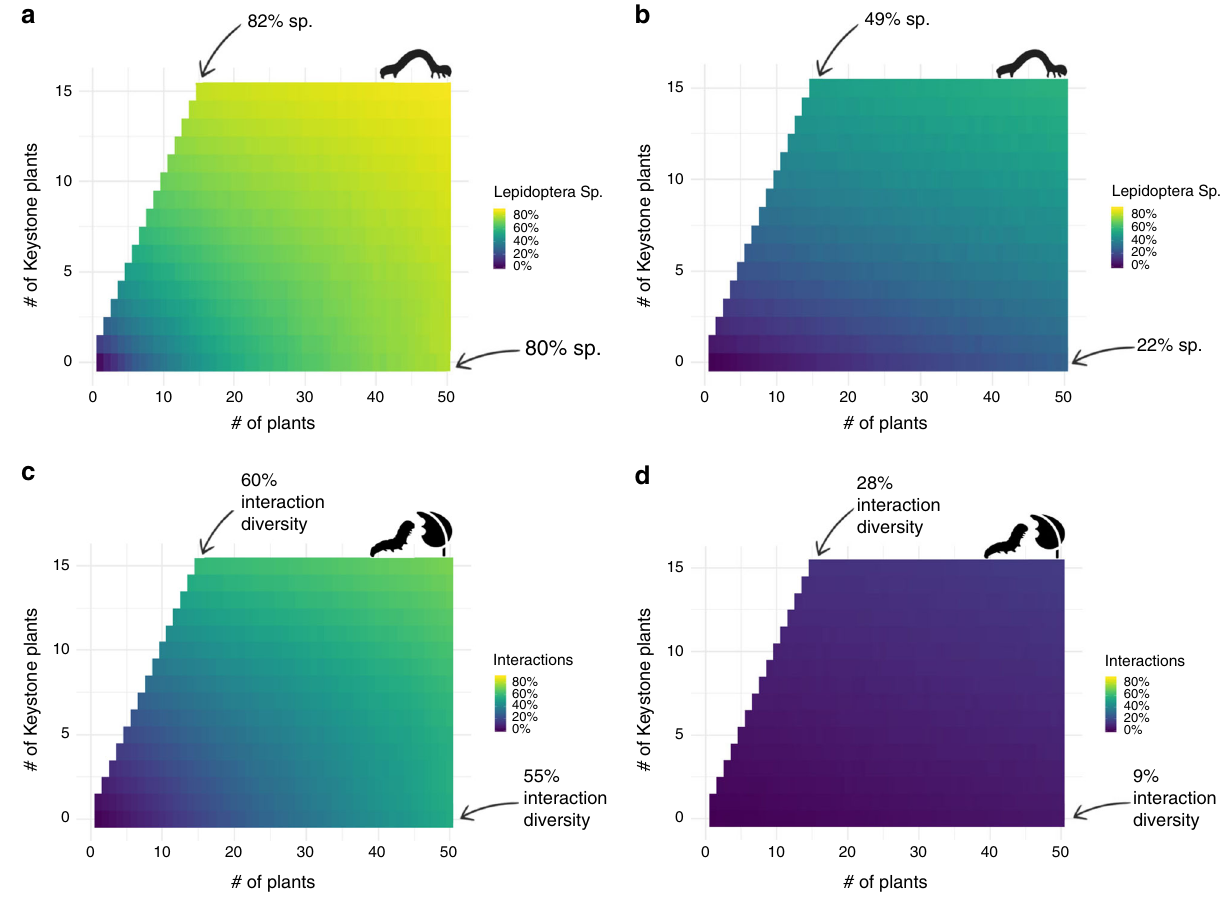
“ Fig. 3 including woody and herbaceous keystone plants increases the ef fi cacy and ef fi ciency of the restoration of Lepidoptera diversity. Simulations of restoration scenarios where (a) Lepidoptera diversity on woody plants, (b) Lepidoptera diversity on herbaceous plants, (c) interaction diversity on woody plants, and (d) interaction diversity on herbaceous plants as numbers of plant genera ( x -axis) and keystone plant genera ( y -axis) increase. For comparisons across counties, percent species and percent interactions from total possible is used in lieu of raw numbers. For both woody (left column) and herbaceous plants (right column), supported caterpillar species and interactions were higher with fewer plants when keystone plant species were included. In woody plants, more than twice the number of plant genera was required to achieve the species and interactions produced by keystone plants. In herbaceous plants, comparable richness and interactions were not reached even with a 3-fold increase in plant genera richness. Caterpillar icon in (a, b) from www. phylopic.org; caterpillar and leaf icons in (c, d) made by Freepik [https://www. fl aticon.com/authors/freepik] from www. fl aticon.com. ” Which replaces the previous incorrect version: “ Fig. 3: Including woody keystone plants increases the ef fi cacy and ef fi ciency of the restoration of Lepidoptera diversity. Simulations of restoration scenarios where (a, b) Lepidoptera diversity and (c, d) interaction diversity as numbers of plant genera ( x -axis) and keystone plant genera ( y -axis) increase in woody and herbaceous plants. For comparisons across counties, percent species and percent interactions from total possible is used in lieu of raw numbers. For both woody and herbaceous plants, supported caterpillar species and interactions were higher with fewer plants when keystone plant species were included. In woody plants, more than twice the number of plant genera was required to achieve the species and interactions produced by keystone plants. In herbaceous plants, comparable richness and interactions were not reached even with a 3-fold increase in plant genera richness. Caterpillar icon in ( a , b ) from www.phylopic.org; caterpillar and leaf icons in ( c , d ) made by Freepik [https://www. fl aticon.com/authors/freepik] from www. fl aticon.com.